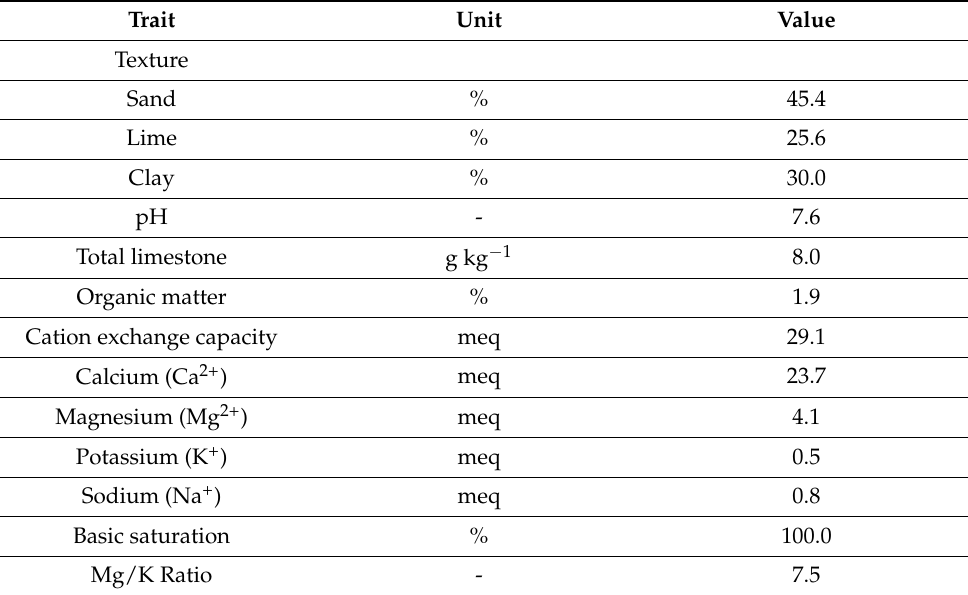
Table 1. Main physical and chemical soil characteristics in the experimental almond orchard located at Tarquinia municipality (Latium region—Italy) at the ARSIAL experimental farm.